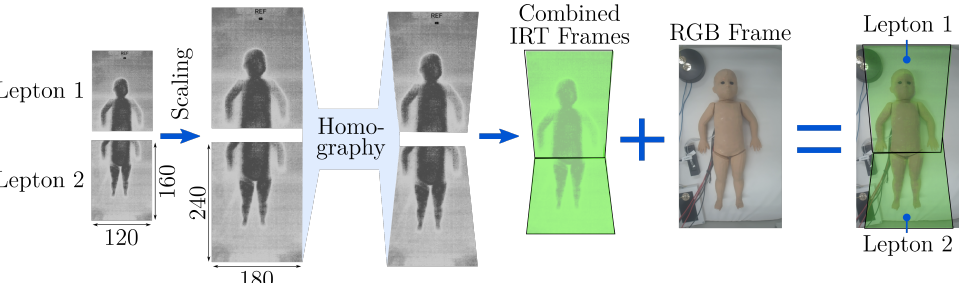
Figure 6. Overview of the registration